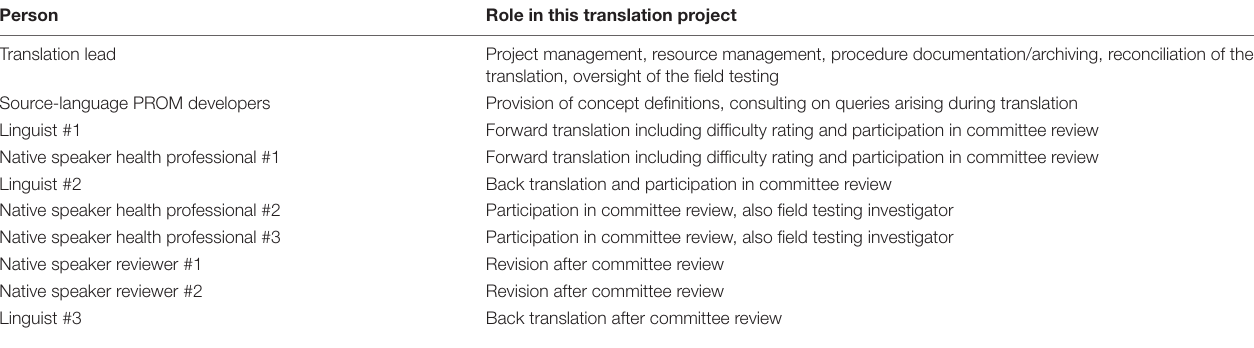
TABLE 2 | People involved in this translation project along with their